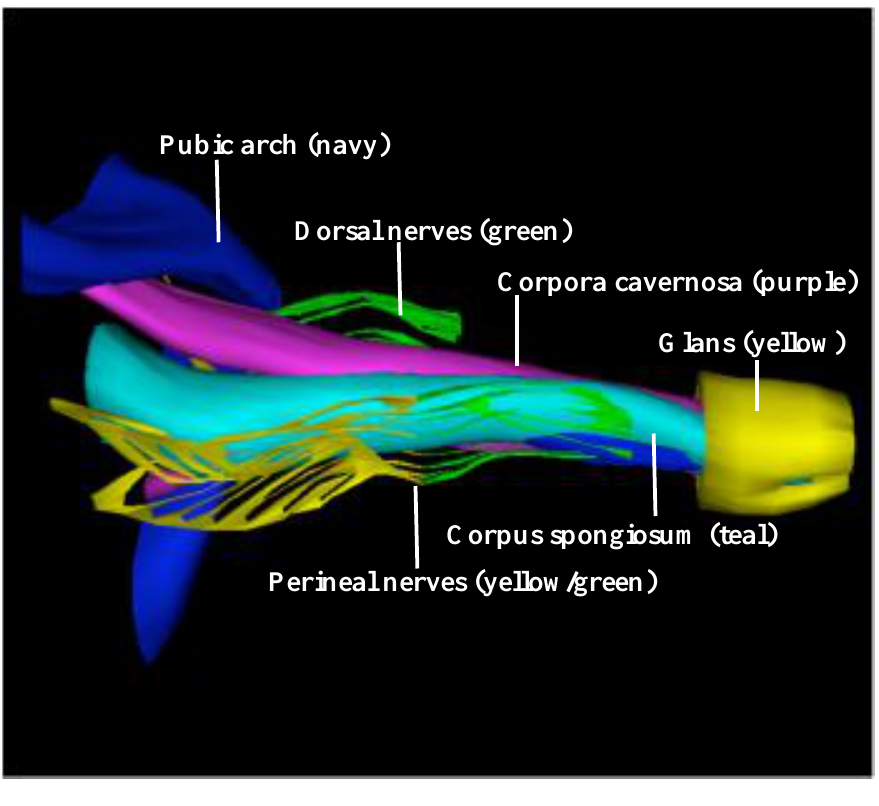
FIGURE 3. Ventral-lateral view: 3-dimensional reconstruction of penile anatomy.